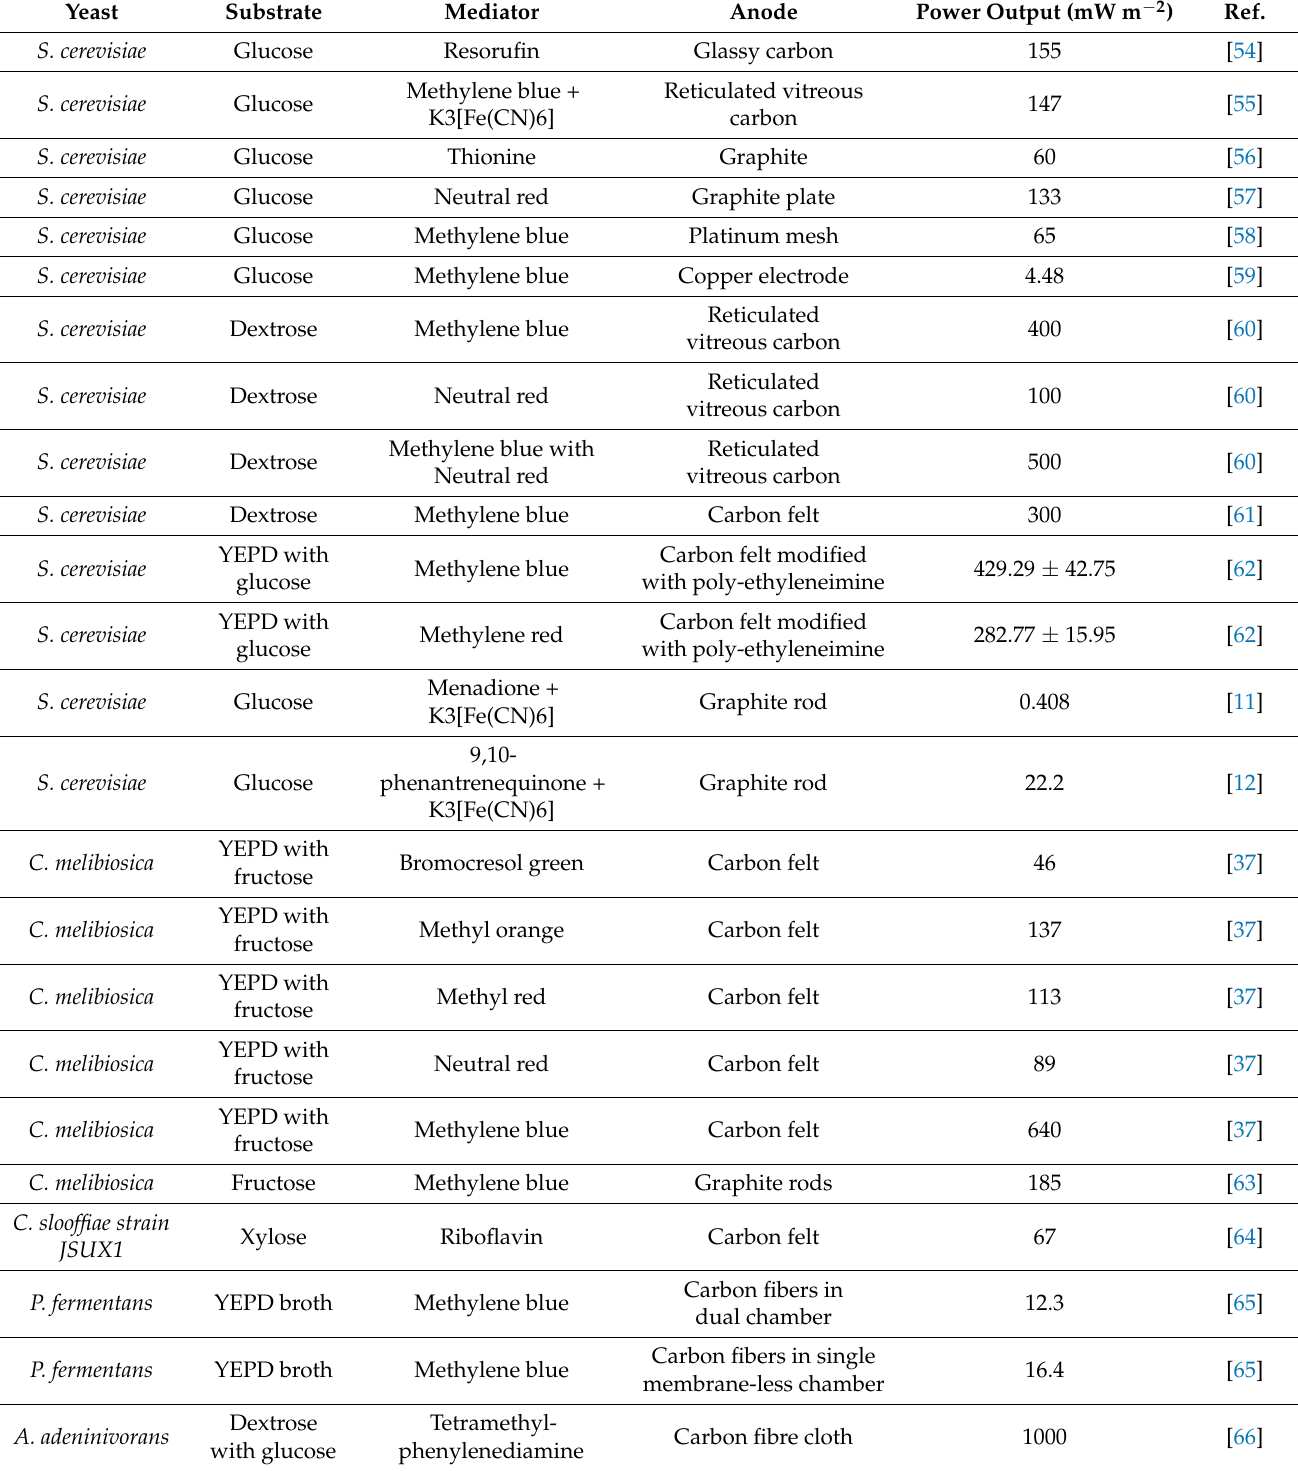
Table 1. Description of the performance of various yeast-based MFCs using respective mediators for the systems. Abbreviation YEPD stands for “yeast extract peptone